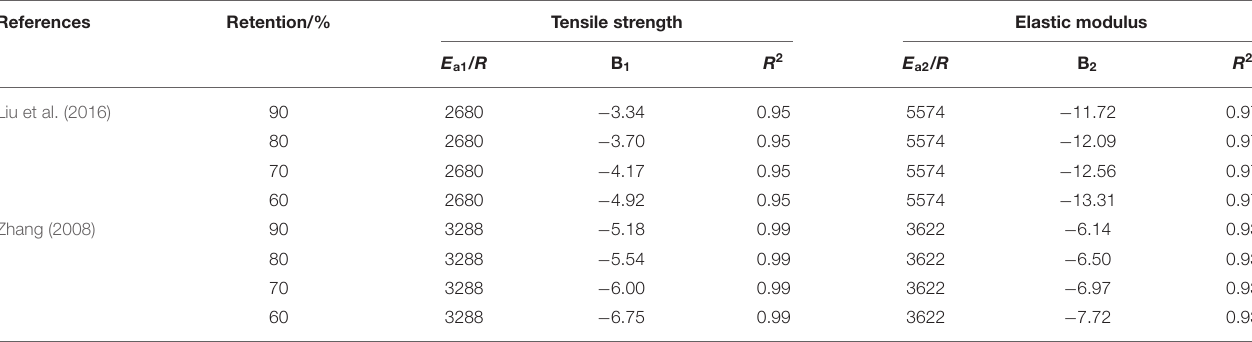
TABLE 3 | Coefficients of regression equations for Arrhenius plots.